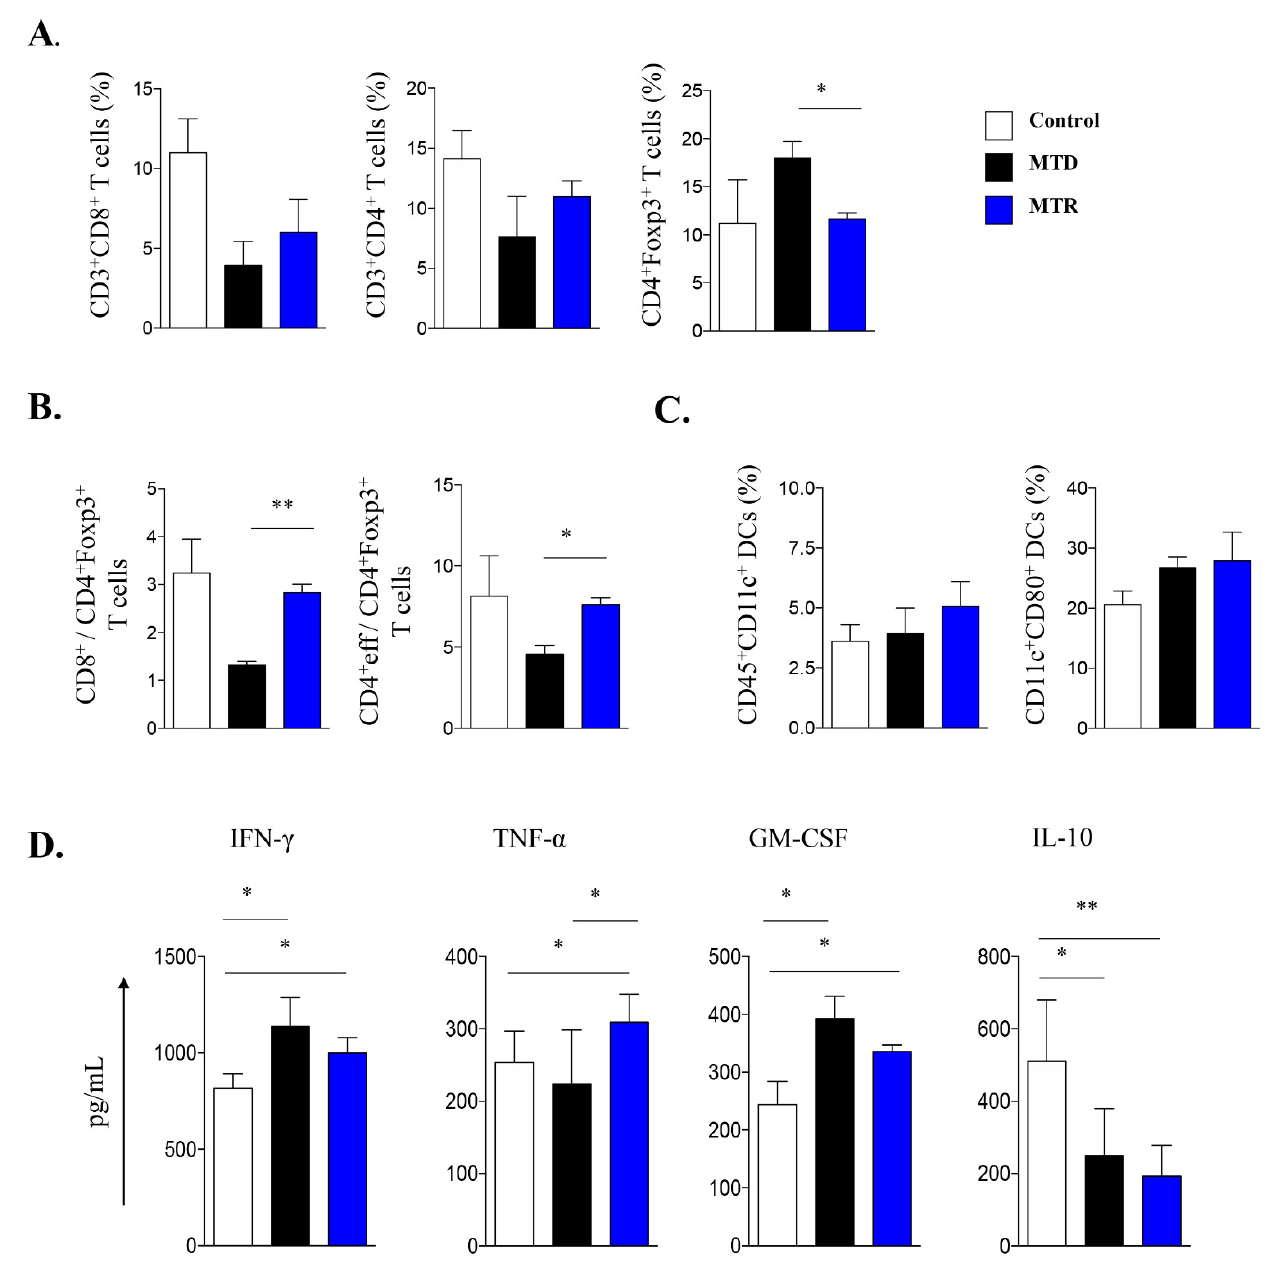
Figure 4. Immune cell composition in the tumor microenvironment (TME) upon MTD and MTR administration in a metastatic mouse model. ( A ) Cumulative data shown as mean ± SD depict the percentages of CD3 + CD8 + cells, CD3 + CD4 + cells and CD4 + Foxp3 + Treg cells infiltrating lung tumors isolated by control-, MTD- or MTR-treated mice as in Figure 3B. ( B ) CD8 + Teff/CD4 + Foxp3 + Treg and of CD4 + Teff/Treg cell ratios in lung tumors are shown as indicated. ( C ) Cumulative data, shown as mean ± SD, depict the percentages of CD45 + CD11c + DCs and CD11c + CD80 + DCs, gated on CD45 + cells in lung tumors. Data are mean ± SD from n = 6–8 mice/group from 2 independent in vivo experiments. ( D ) IFN- γ , TNF- α , GM-CSF, and IL-10 cytokine release in cell culture supernatants of lung DLN cells re-stimulated ex vivo with antibodies against CD3/CD28. Data are mean ± SD of triplicate wells. Statistical analysis was performed by Student’s t -test; * p < 0.05 and ** p < 0.01.